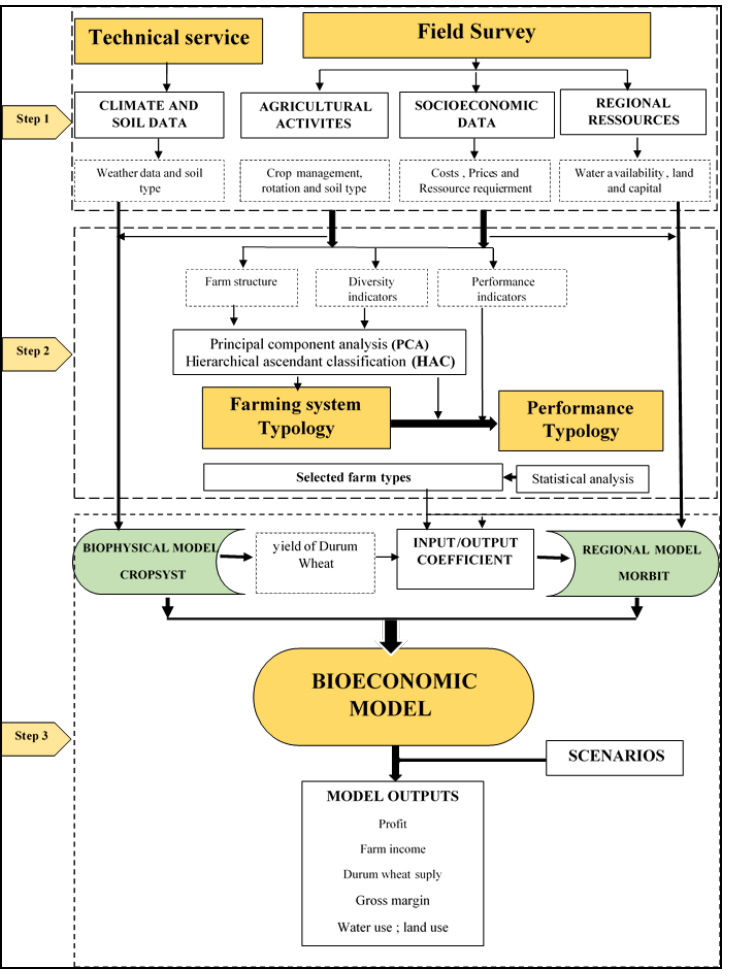
Figure 1. Framework of the analyses.